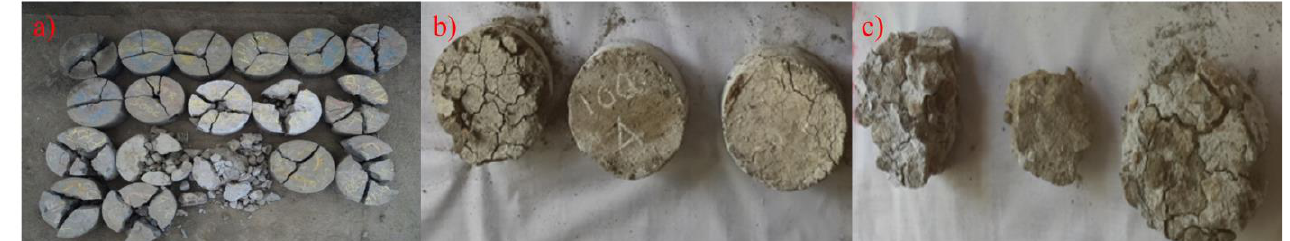
Figure 11. Failure pattern of specimens after impact testing at elevated temperatures. ( a ) Reference specimen at ambient temparature after testing. ( b ) Impact specimens exposed to 750 °C. ( c ) Impact specimens exposed to 1000 °C.